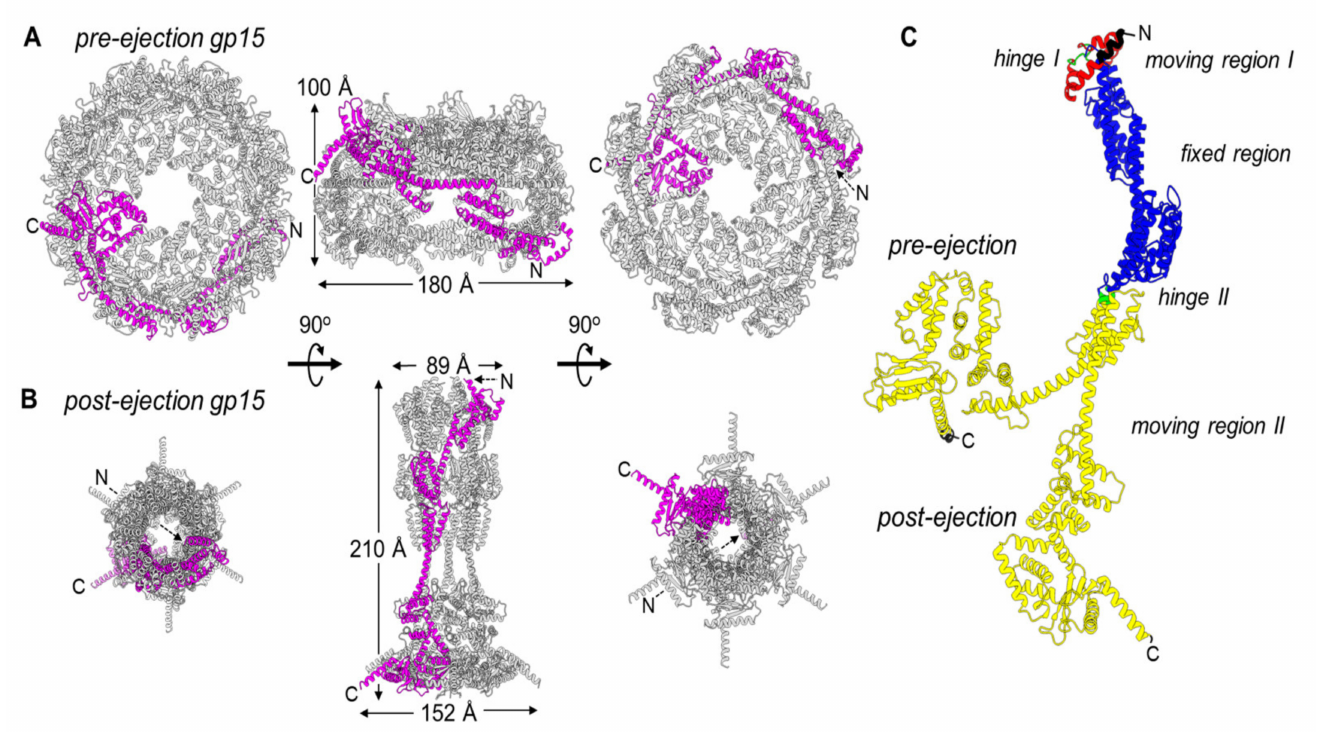
Figure 2. Gp15 conformational gymnastics from pre- to post-ejection. ( A ) Octameric assembly of gp15 in the pre-ejection internal core stack shown in top, side, and bottom views. ( B ) Hexameric gp15 assembly in the post-ejection conformation. In both panels A and B, only one gp15 protomer is colored in magenta. ( C ) DynDom analysis of gp15 flexible regions. Residues colored in blue are superimposable (RMSD ~ 2 Å), red and green move significantly (RMSD > 4 Å), and the entire gp16-C, in yellow, undergoes dramatic restructuring (RMSD > 10 Å). The residues in black, not modeled in the pre-ejection conformation, were not